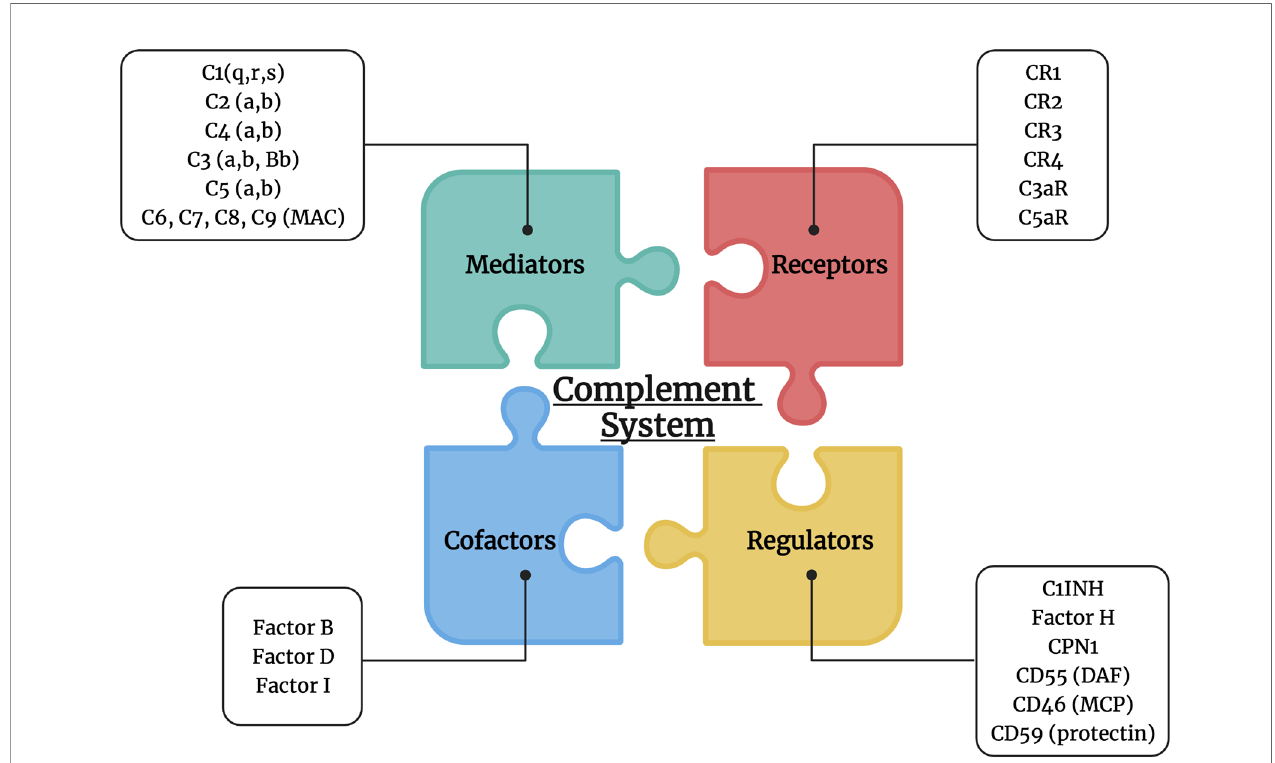
FIGURE 1 | Complement system players. The complement system is composed of multiple mediators (C1, C2, C4, C3, C5, MAC: C6, C7, C8, and C9), cofactors (factor B, D and I), receptors (CR1, CR2, CR3, CR4, C3aR, and C5aR), and regulators (C1INH, factor H, CPN1, CD55, CD46, and